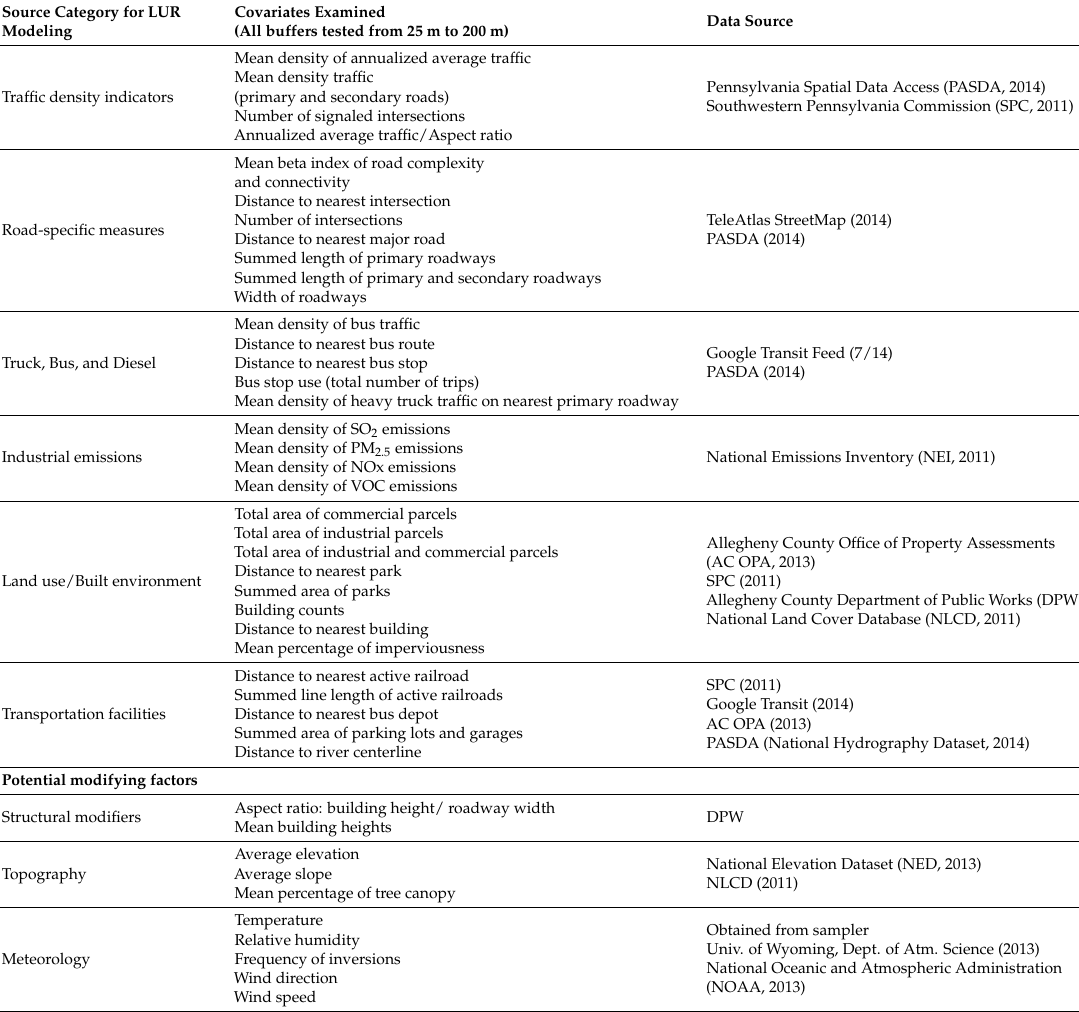
Table 1. GIS (Geographic information system)-based source density indicators used for LUR (land use regression) modeling of factor